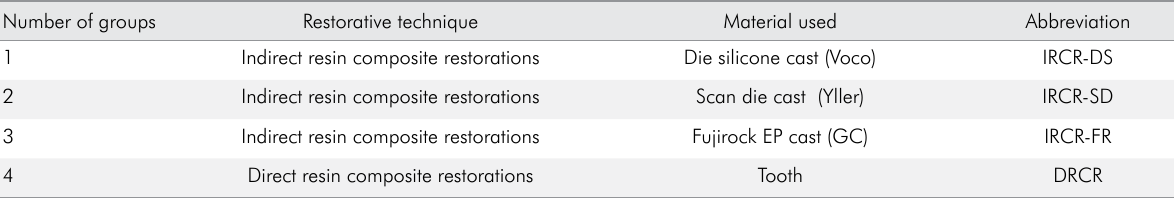
Table 1. Description of the experimental groups.